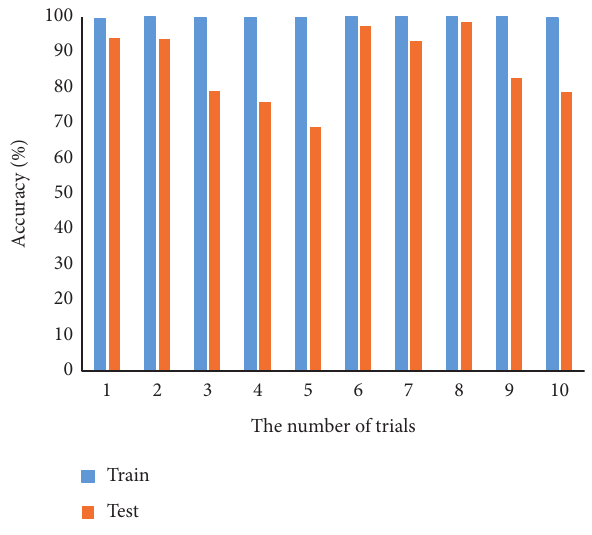
Figure 10: Performance of the W-CONV model.